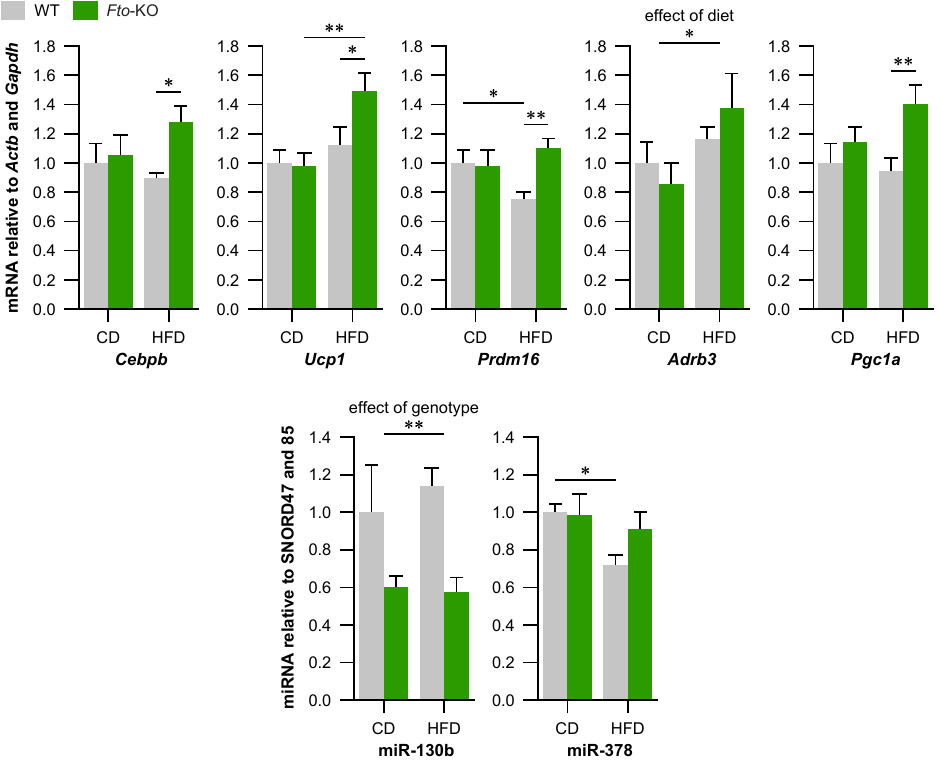
Figure 2. Relative expression of mRNAs and miRNAs related to BAT adipogenesis and metabolism in interscapular BAT. The amount of mRNA was normalized using Actb and Gapdh as reference genes and the amount of miRNA was normalized using SNORD47 and SNORD85 as internal controls. WT, wild-type mice; Fto -KO, Fto -knockout mice; CD, control diet; HFD, high-fat diet. Results are shown as mean ± SEM ( n = 5–9 per group in mRNA, n = 4 per group in miRNA). Two-way ANOVA followed by simple main effects analysis with Bonferroni correction if there was significant interaction effect or moderation effect, * p < 0.05, ** p < 0.01.